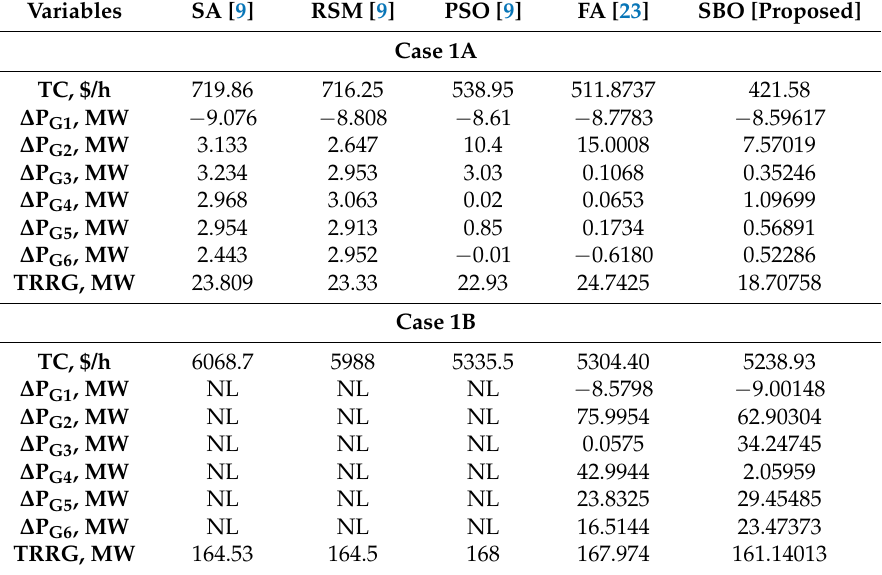
Table 3. Comparison of simulation results for modified IEEE 30-bus test power system. SA: simulated annealing; RSM: random search method; (PSO): particle swarm optimization; FA: firefly algorithm; SBO: satin bowerbird optimization.